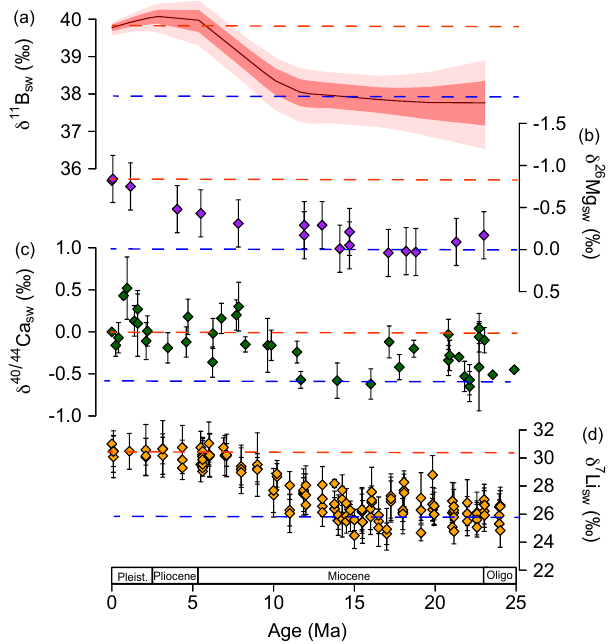
Figure 12. (a) The δ 11 B sw curve from this study plotted with other trace element isotopic records. On the δ 11 B sw panel the darker shaded area highlights the 68% confidence interval and the lighter interval highlights the 95% confidence interval, (b) δ 26 Mg sw record from Pogge von Strandmann et al. (2014) (error bars are ± 0.28‰ and include analytical uncertainty and scatter due to the spread in modern O. universa and the offset between the two analysed species), (c) δ 44 / 40 Ca sw record from Griffith et al. (2008) (error bars show 2 σ uncertainty) and (d) δ 7 Li sw record from Misra and Froelich (2012) (error bars show 2 σ uncertainty). Blue dashed lines show middle Miocene values and red dashed lines highlight the